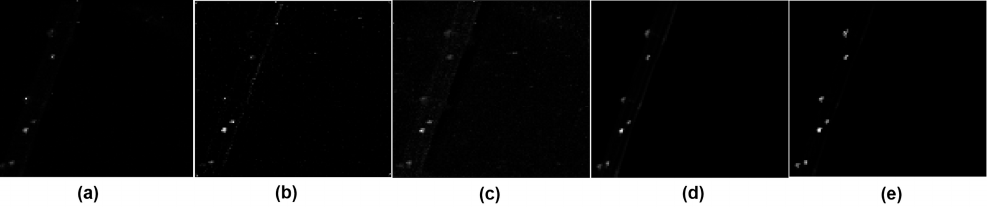
Figure 9. The normalized detection maps of PaviaC dataset before threshold segmentation: ( a ) GRX; ( b ) LRX; ( c ) CRD; ( d ) LRaSMD; and ( e ) RSLAD.